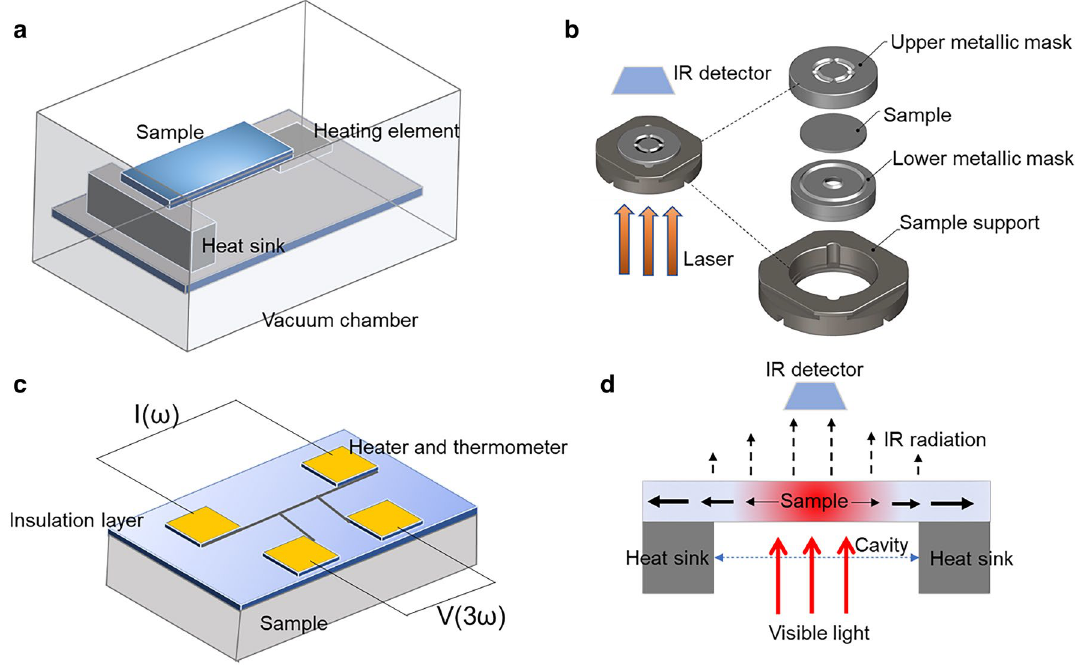
Fig. 5 The widely used thermal conductivity measurements to test the in‑plane k of films: a thermal bridge method, b flash method, c 3 ω method, and d steady‑state infrared